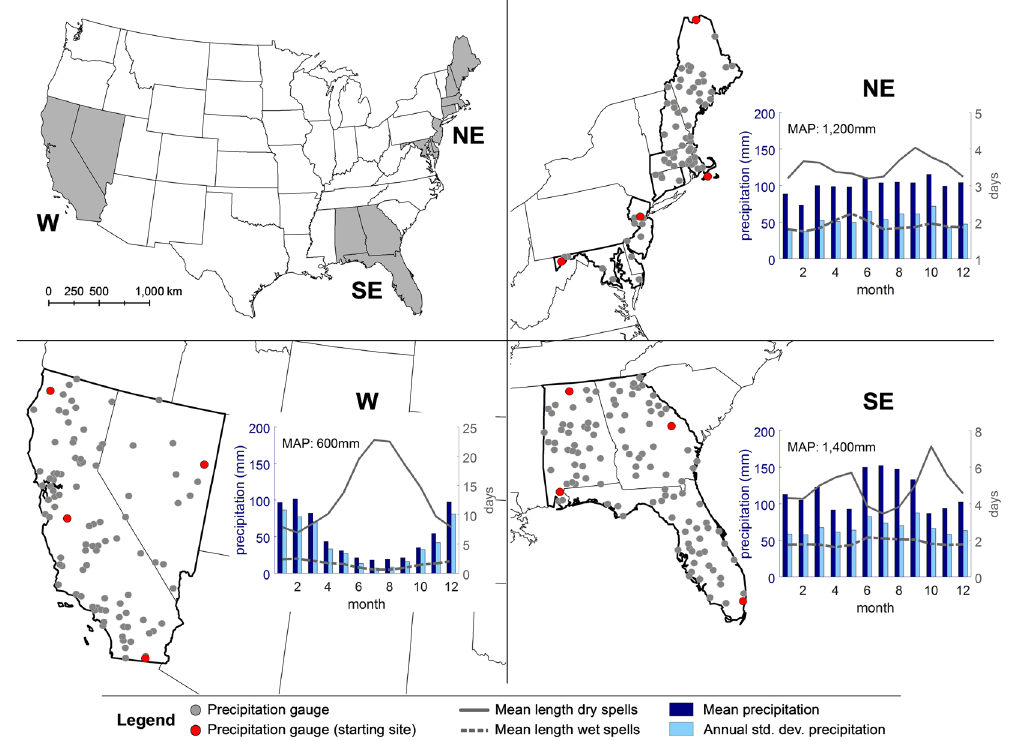
Figure 1. The three study areas in the North-East (NE), South-East (SE) and West (W) of the United States, including the location of all precipitation gauges available for the period 1986–2015 (grey dots), the starting sites of the experiments (see section ‘Design of the experiments’ below), plots of the mean precipitation, annual standard deviation of precipitation, mean length of dry and wet spells, averaged over all gauges for each month. The bar/line plots also contain information on the mean annual precipitation (MAP). The map was generated in ArcGIS 10.2 (http://www.esri.com/), related bar/line plots in MATLAB 2016a (http://www.mathworks.com/).